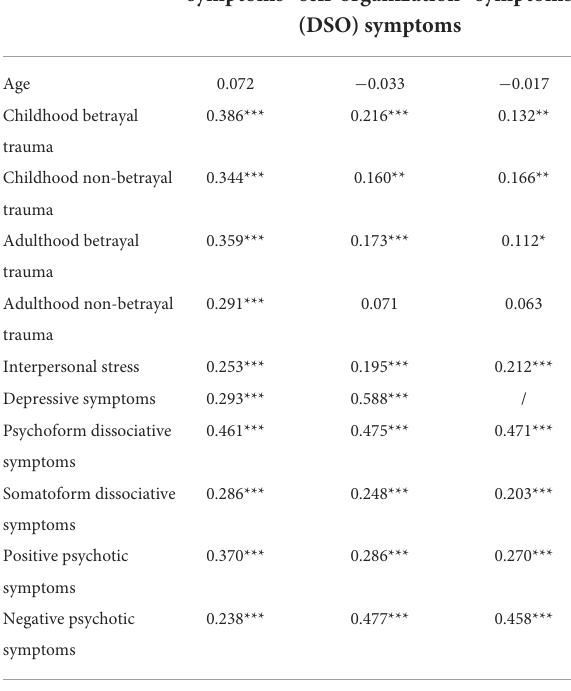
TABLE 3 Correlations between post-traumatic stress disorder (PTSD), disturbances in self-organization (DSO) symptoms, and depressive symptoms and other clinical variables ( N =